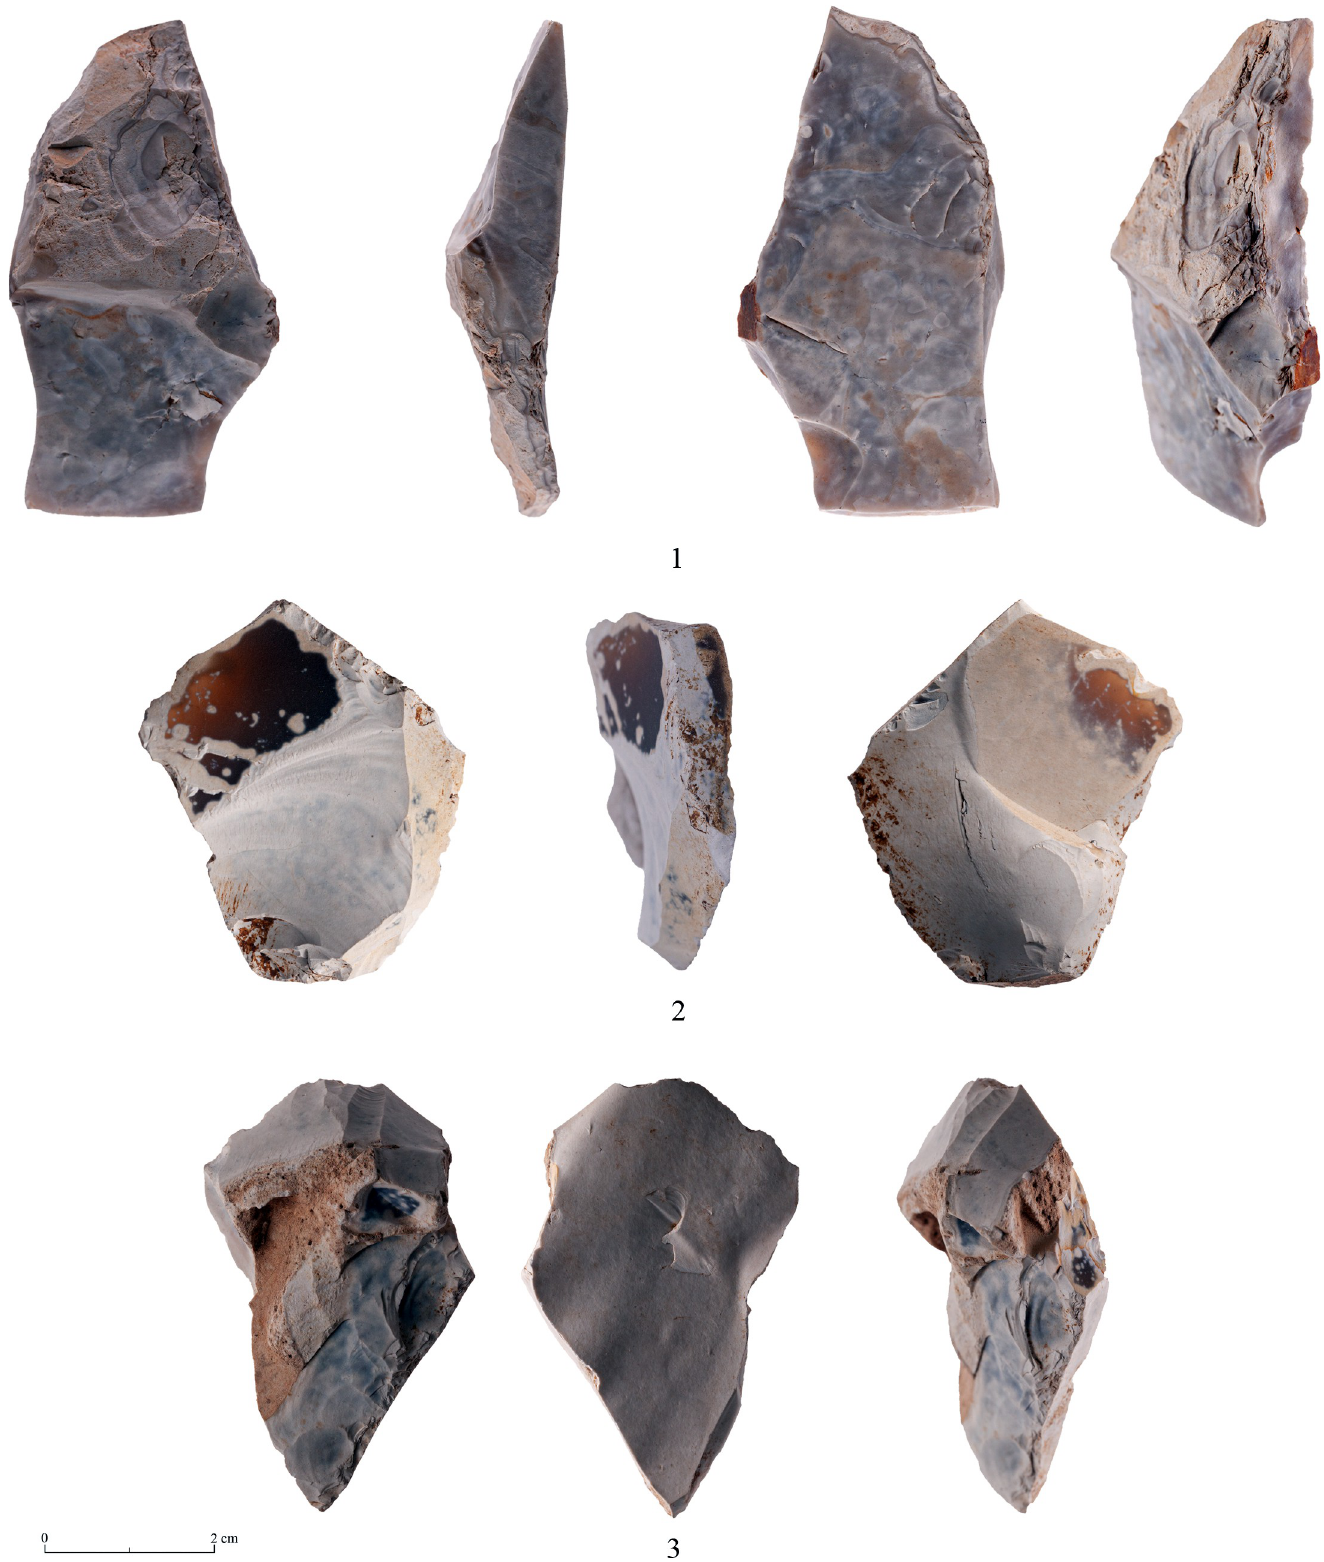
Fig 28. Waste products typical of the early stages of biface production.